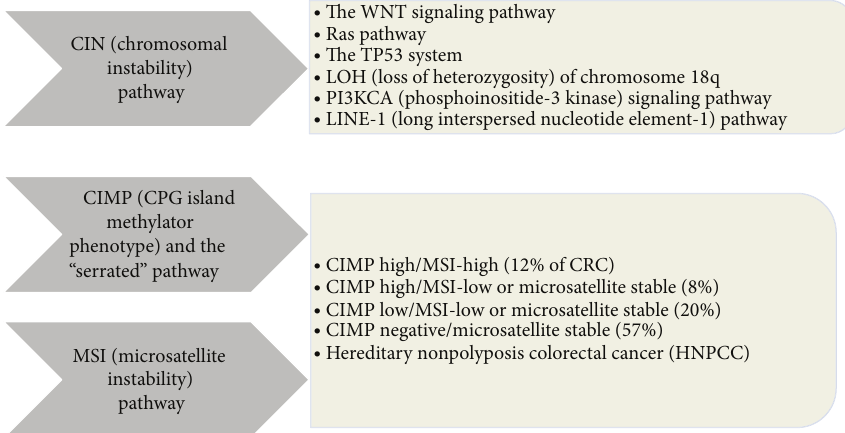
Figure 1: Classifying CRC based on the presence of MSI and CIMP